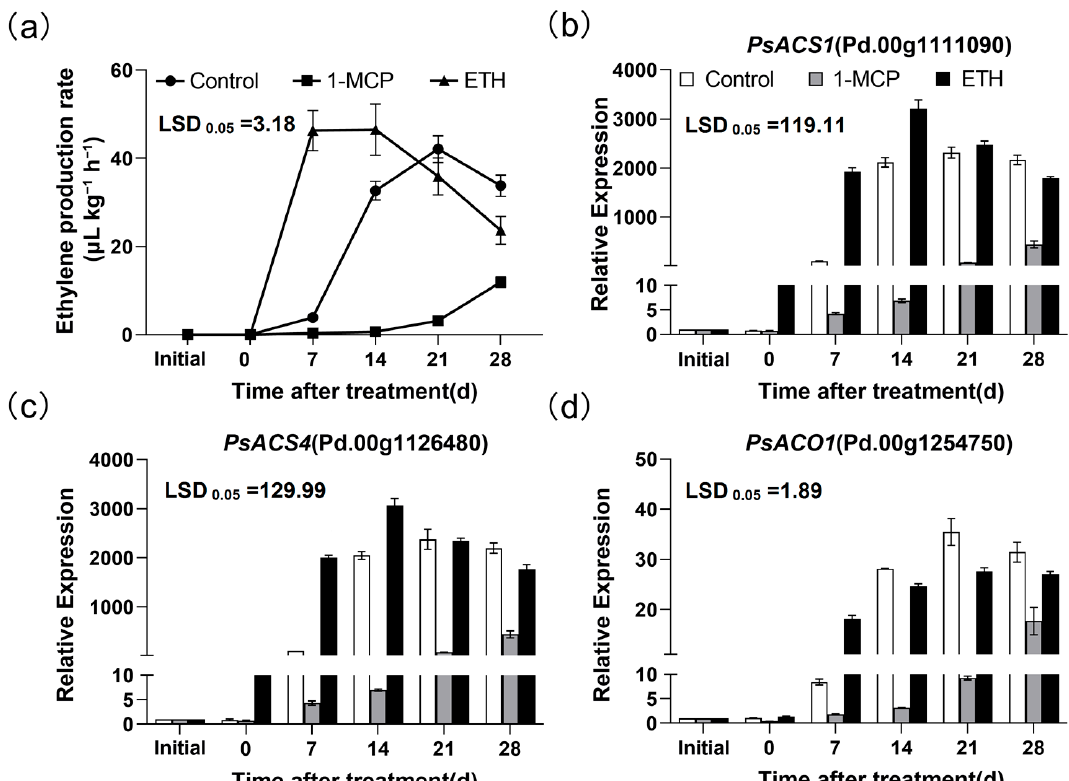
Figure 5. Effects of 1-MCP (1.0 μ L L − 1 ) and ETH (100.0 μ L L − 1 ) treatments on the ethylene production rate ( a ) and expression profiles of genes associated with ethylene biosynthesis ( b – d ) in ‘Friar’ plum fruit under 10 °C storage. “Initial” represents the time point before ethylene and 1-MCP treatments. The vertical bar represents the standard error while the LSD values show significant differences at the 0.05 level.